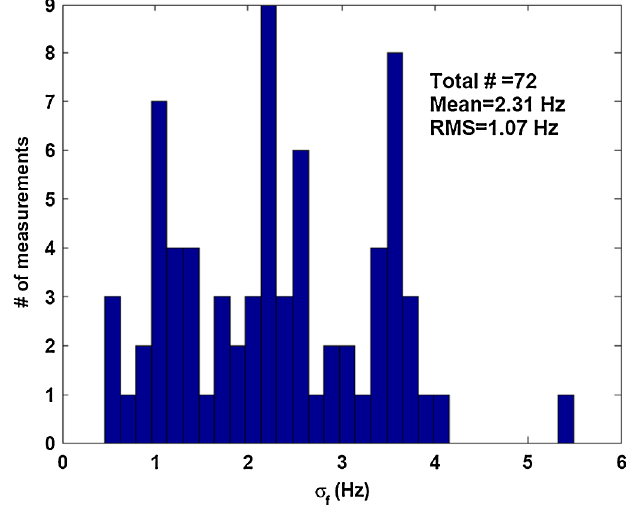
FIG. 8. (Color) A histogram showing the open loop rms detun- ing values of microphonics measurements taken at HoBiCaT for a loaded quality factor of 3 (cid:6) 10 7